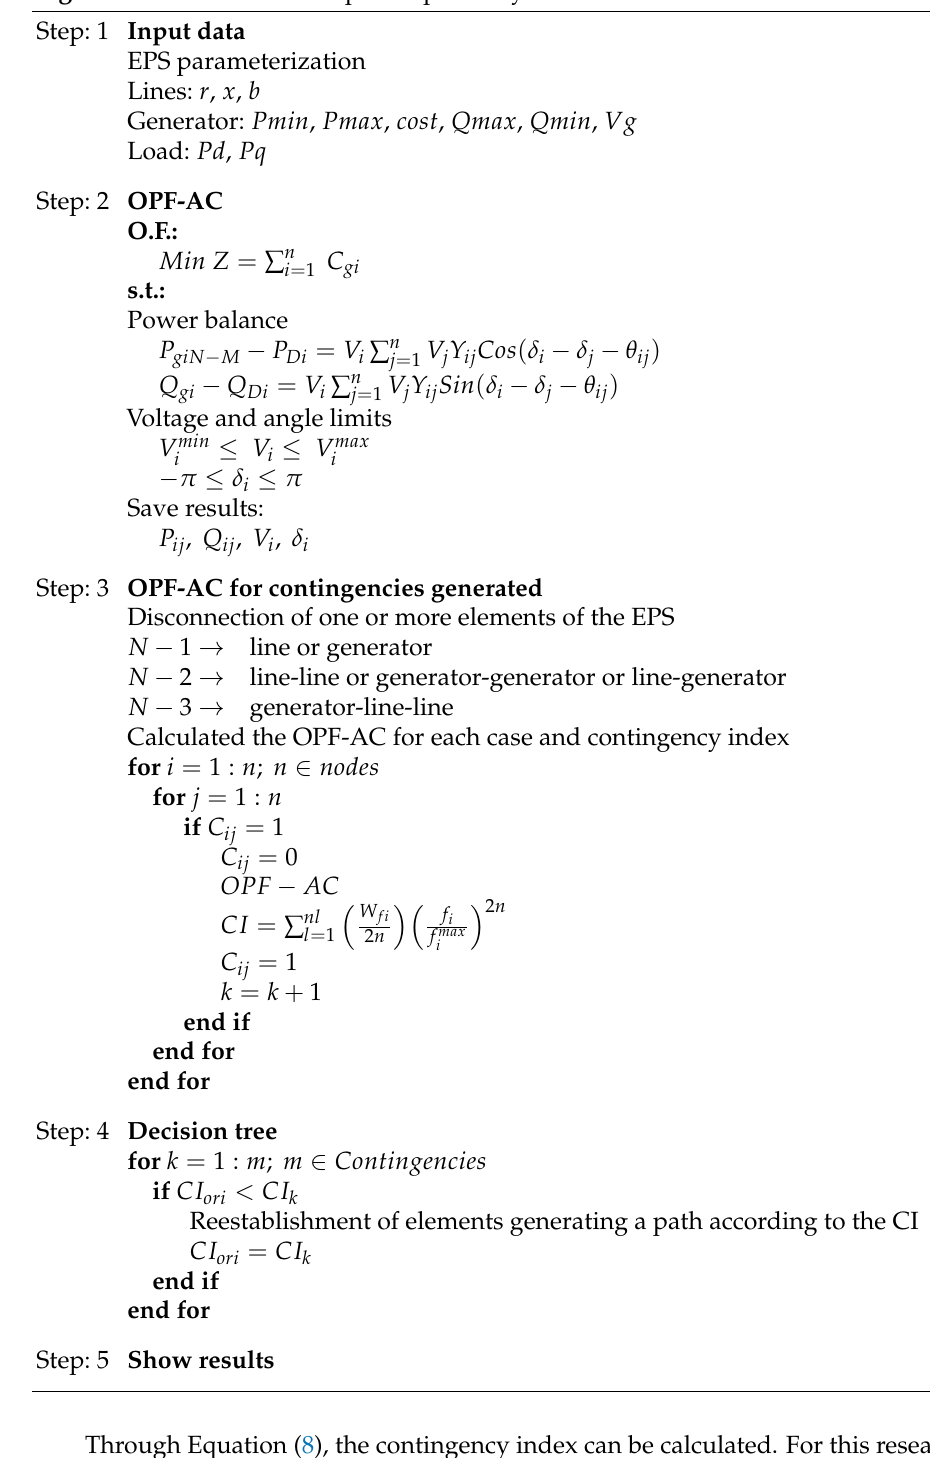
Algorithm 1 Heuristics for optimal power systems